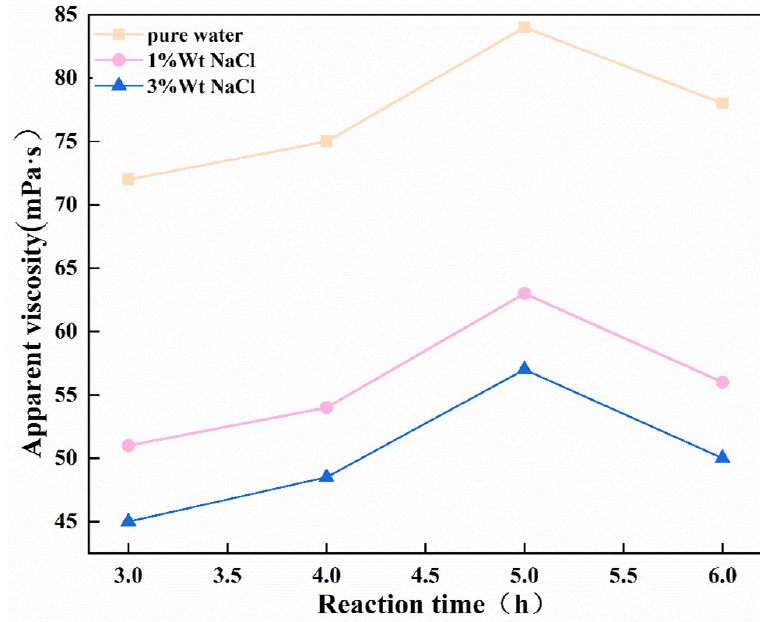
Figure 2. Effect of reaction time on viscosity.